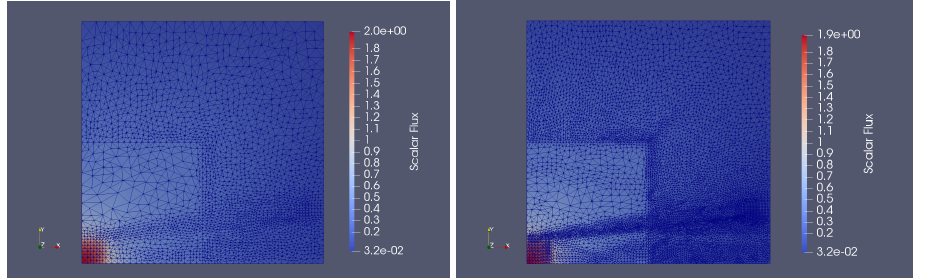
Figure 3. Scalar flux and adapted mesh using 6 thousand ( left ) and 26 thousand ( right ) element mesh.